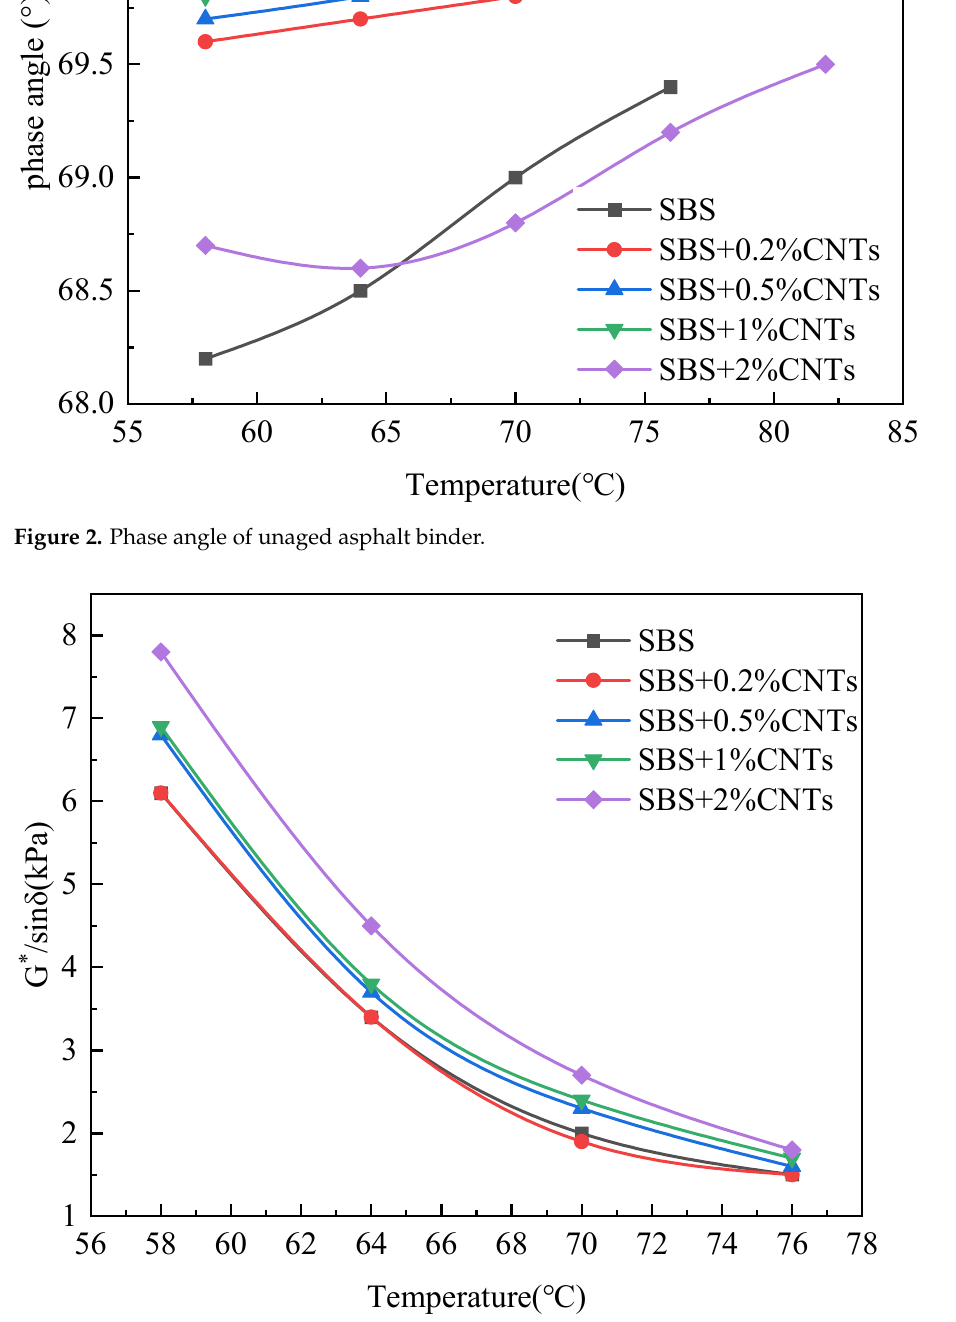
Figure 3. Relationship between G*/sinδ and temperature after UV aging.